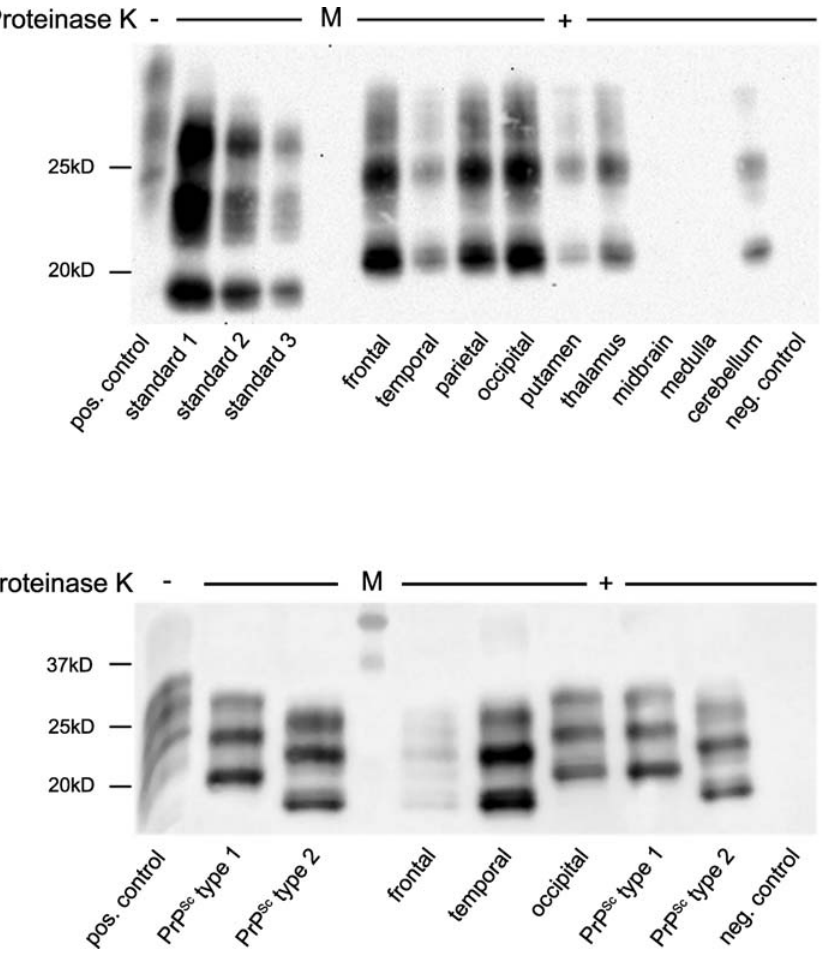
Figure 2. Western Blots Illustrating the Principle of PrP Sc Profiling and the Co-Occurrence of Multiple PrP Sc Types within One Patient with sCJD (Upper panel) The PrP Sc content in various central nervous system regions (indicated below respective lanes) was quantified by plotting the signal intensity on a standard curve created by a serially diluted PrP Sc standard (standard 1 to 3). Proteinase K digestion is indicated above lanes. (Lower panel) Presence of a faster-migrating unglycosylated band of PrP Sc ( ; 19 kDa, PrP Sc type 2, frontal and temporal cortex) and a slower-migrating unglycosylated band of PrP Sc ( ; 21 kDa, PrP Sc type 1, occipital cortex) within one patient with sCJD (codon 129 MM). Controls include PrP Sc type 1 and 2 and a sample from a non prion-diseased individual. Proteinase K digestion is indicated above lanes. DOI: 10.1371/journal.pmed.0030014.g002